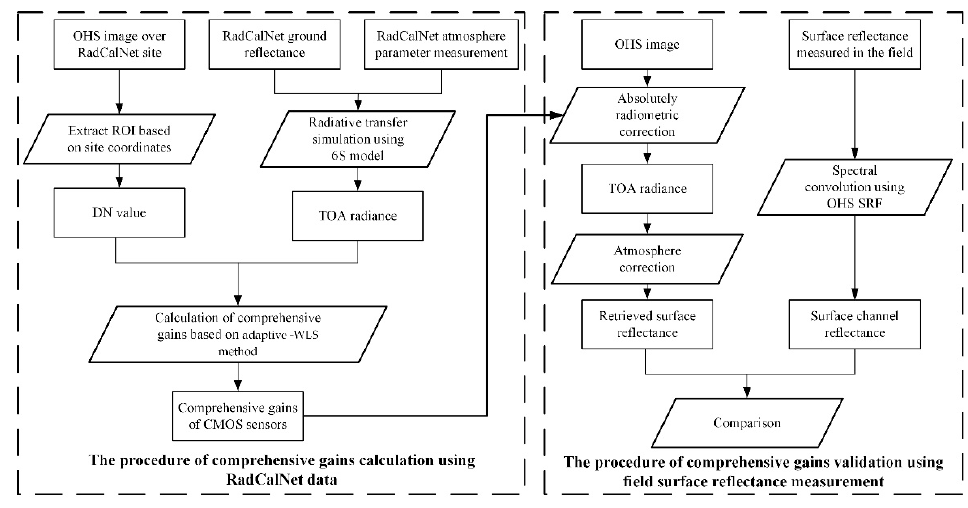
Figure 8. Flow chart of the proposed calibration method.